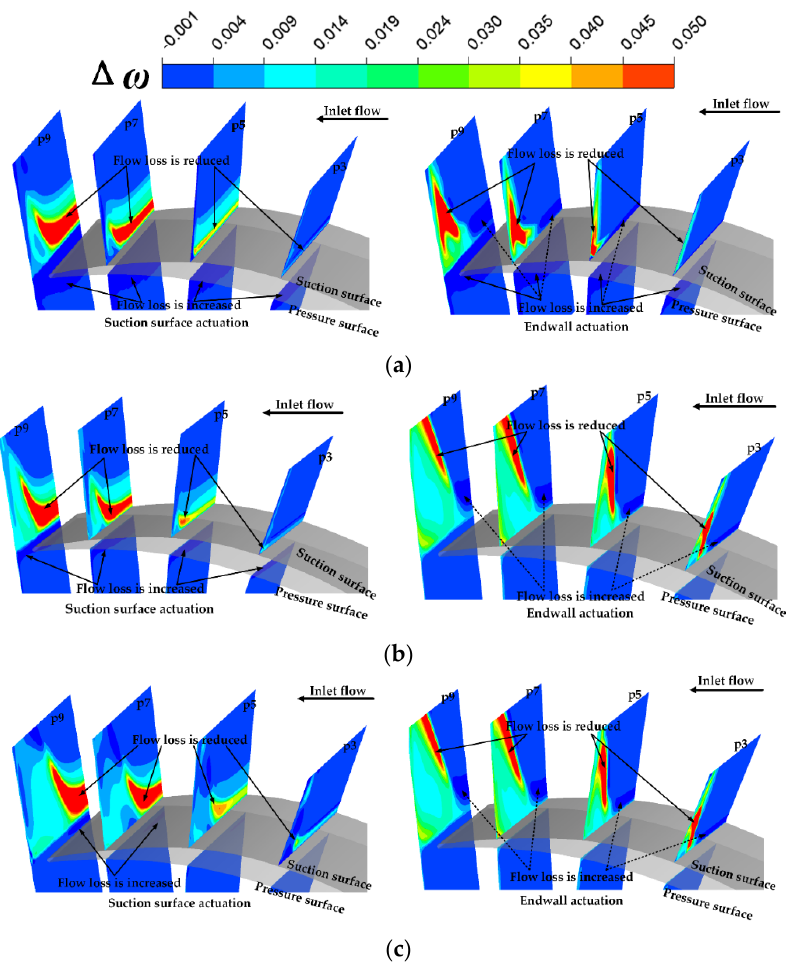
Figure 8. Influences of plasma actuations on the high-speed compressor cascade flow loss at different streamwise planes. ( a ) With an incidence angle of − 4°; ( b ) With an incidence angle of 0°; ( c ) With an incidence angle of 8°.